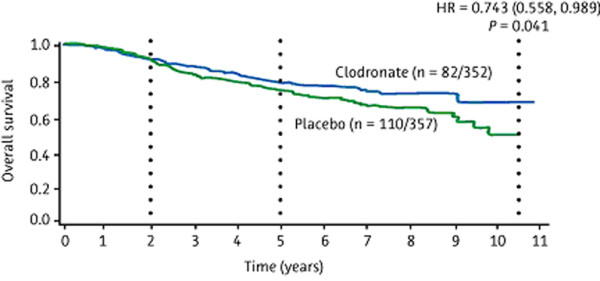
Overall survival in stage II/III patients. HR, hazard ratio.